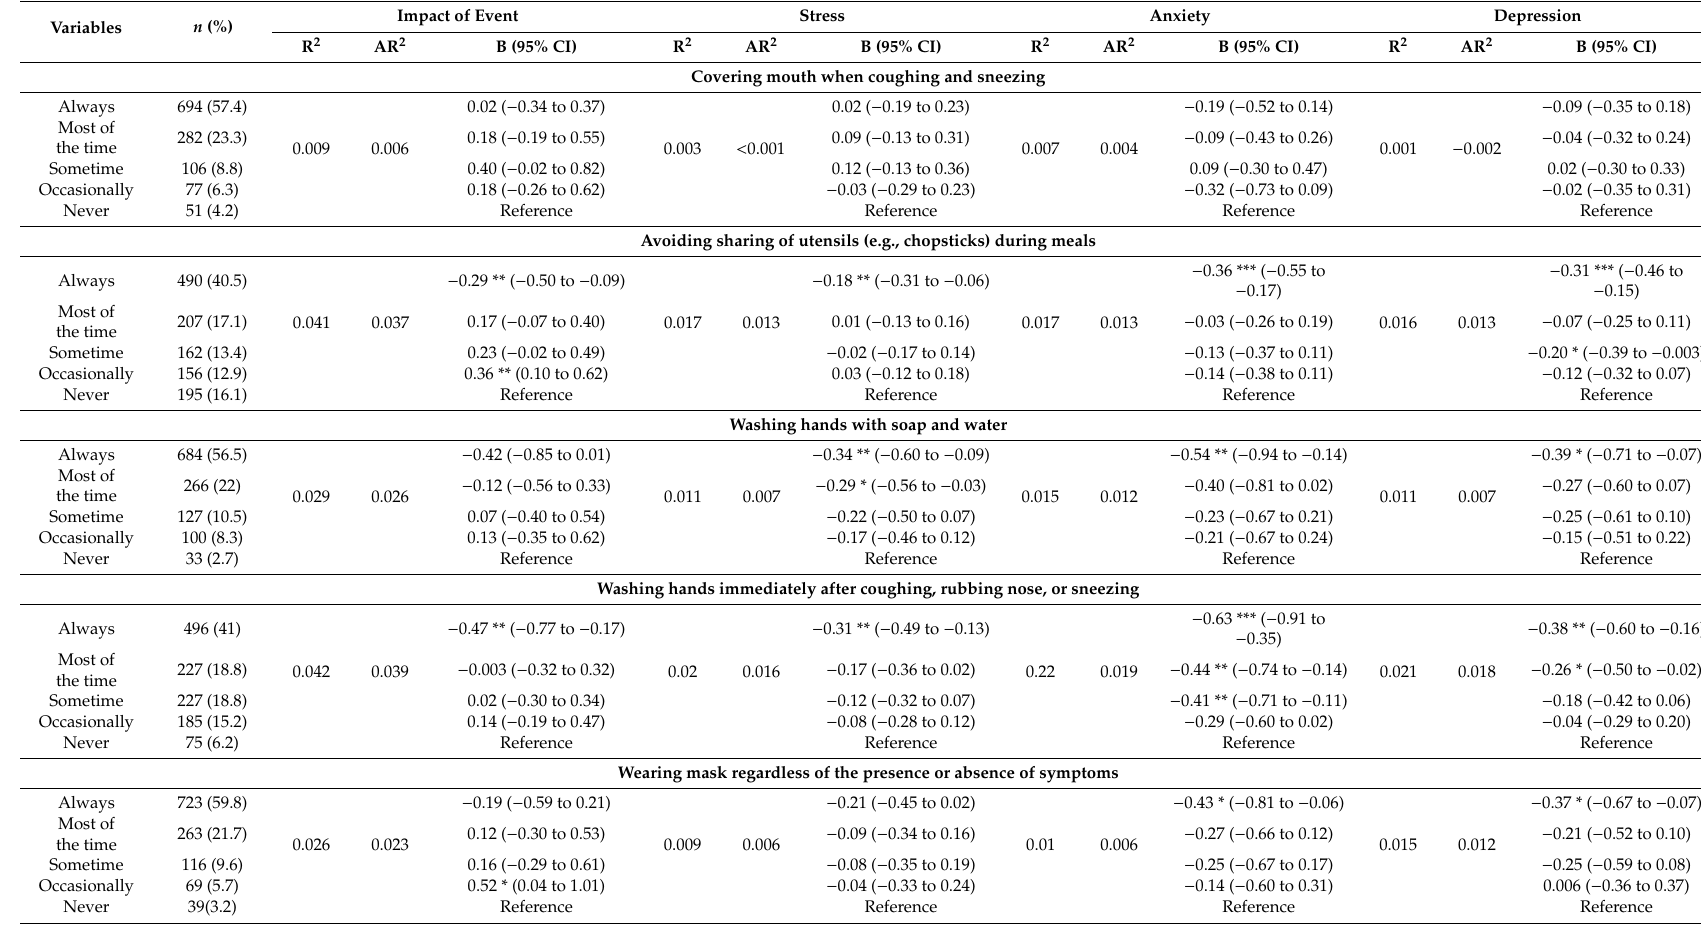
Table 5. Association between precautionary measures in the past 14 days and the psychological impact of the 2019 coronavirus disease (COVID-19) outbreak as well as adverse mental health status during the epidemic ( n =